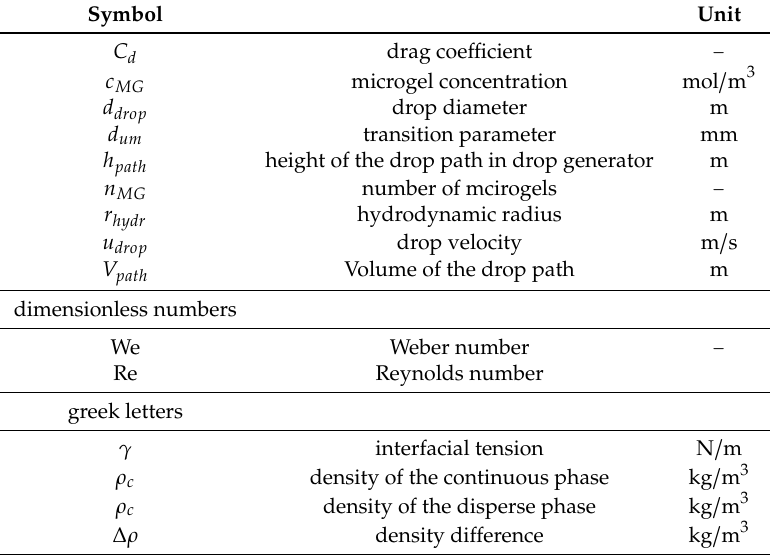
Table A1. List of symbols.